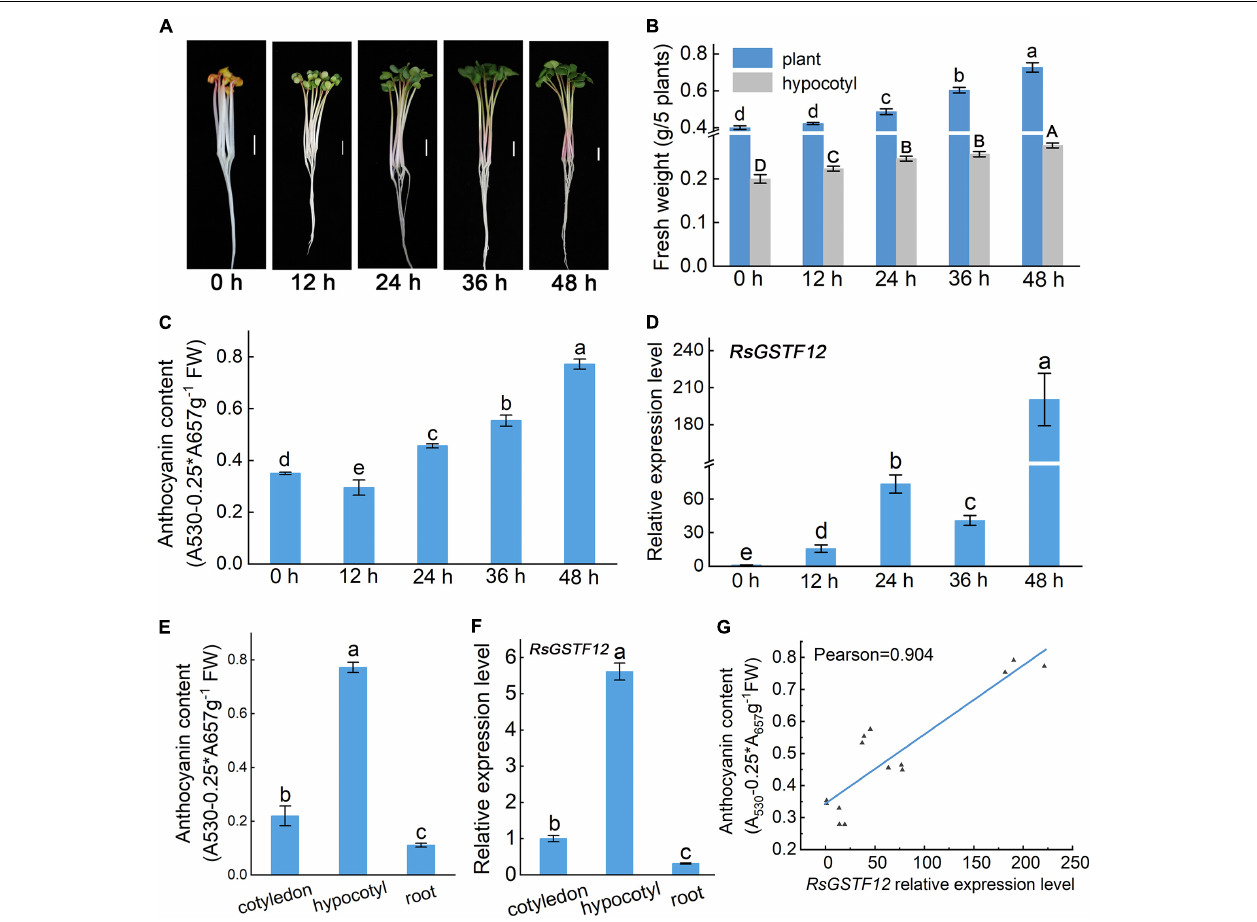
FIGURE 3 | RsGSTF12 has a high correlation with anthocyanin accumulation in radish sprouts. (A) Phenotypes of 3-day-old radish seedlings when transferred into a continuous illumination incubator for 0, 12, 24, 36, and 48 h. Scale bar = 1 cm. (B) Fresh weight of radish seedlings at the five different time points. (C) Anthocyanin content and (D) the relative expression levels of RsGSTF12 in radish hypocotyls at the five time points. (E) Anthocyanin content and (F) the relative expression level of RsGSTF12 in different tissues of radish seedlings. (G) The correlation between the relative expression level of RsGSTF12 and anthocyanin in the hypocotyl of radish. Data in panels (B–F) are presented as the mean ± standard deviation (SD) whose significant differences are indicated by differing letters according to the Duncan’s multiple range test ( p < 0.05). The capital and lowercase letters in panel (B) , respectively, represent significant differences in hypocotyl and the whole plant weight at different time